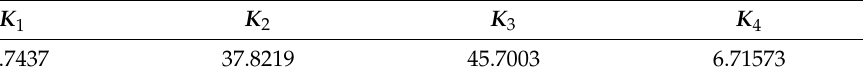
Table 7. LQR controller gains at 80% dip.